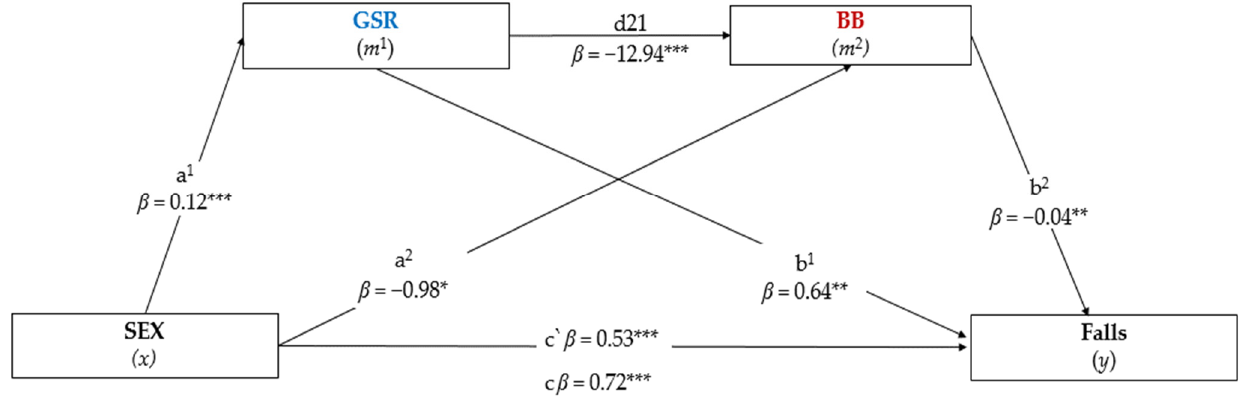
Figure 4. Parallel mediation analysis of the effects of sex (independent variable) on falls (dependent variable) through GSR (gait stability ratio) and BB (body balance). The analysis was based on 5000 bootstrap samples. The indirect effect was statistically significant at the 95% confidence interval (CI) when the CI did not include 0 (zero). Betas ( β ) were reported as the product of simultaneous regression with bootstrap replacement: (1) Path a 1 and a 2 = association between sex with GSR and BB, respectively, (2) Path d21 = association between the two mediation variables ( m 1 and m 2 ), (3) Path b 1 and b 2 = association between GSR and BB with falls, (4 Path c, = direct effect ( x – y ): associations m 1 blue and m 2 dark red = indirect effect ( x – y ) by GSR and BB, respectively. * p < 0.050, ** p < 0.010, *** p < 0.001, c = total effect; c’ = direct effect; a = path Model 1; b = Model 2 path.